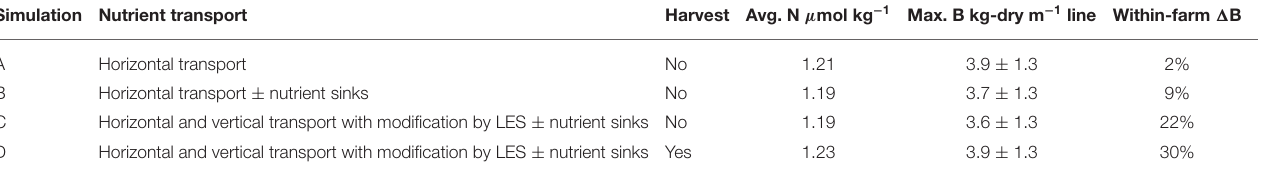
TABLE 2 | Summary of the full-farm simulations (A–D). Simulation Nutrient transport